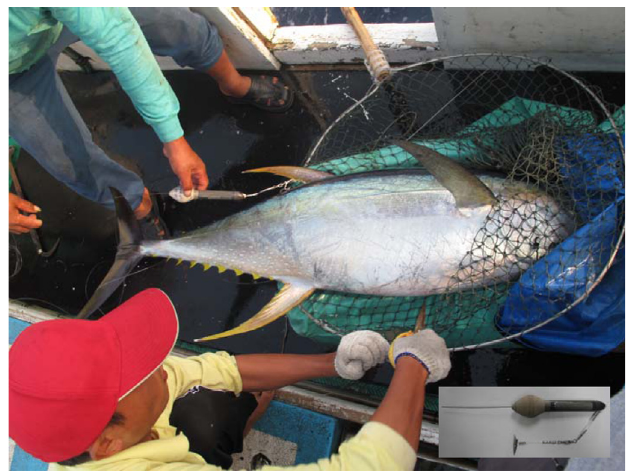
Fig. 1. Picture of a yellow fi n tuna (cm FL) equipped with the pop-up satellite archival tag (MK-10) before